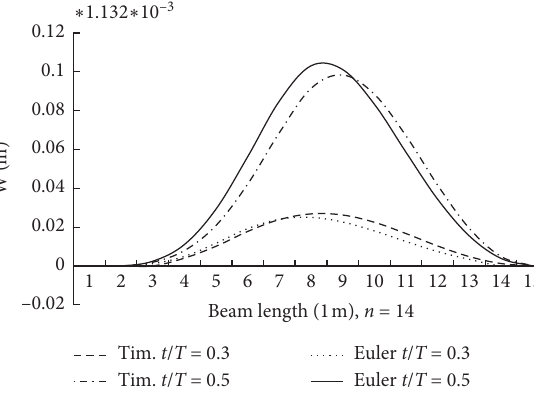
Figure 10: C-S beam (3) deflection, F � 30 N.